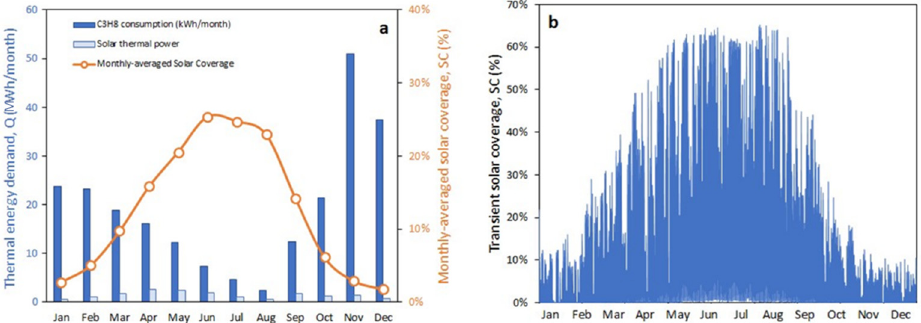
Figure 12. ( a ) Monthly distribution of the thermal energy demand and solar share in the Spanish winery demo site, including the amount of thermal energy delivered by the conventional boiler (C 3 H 8 consumption expressed in kWh/month) and by the solar plant; ( b ) transient solar share. Based on this preliminary result, the role of the latent heat storage on the annual solar share of the winery was evaluated. The simulated yearly solar share results are